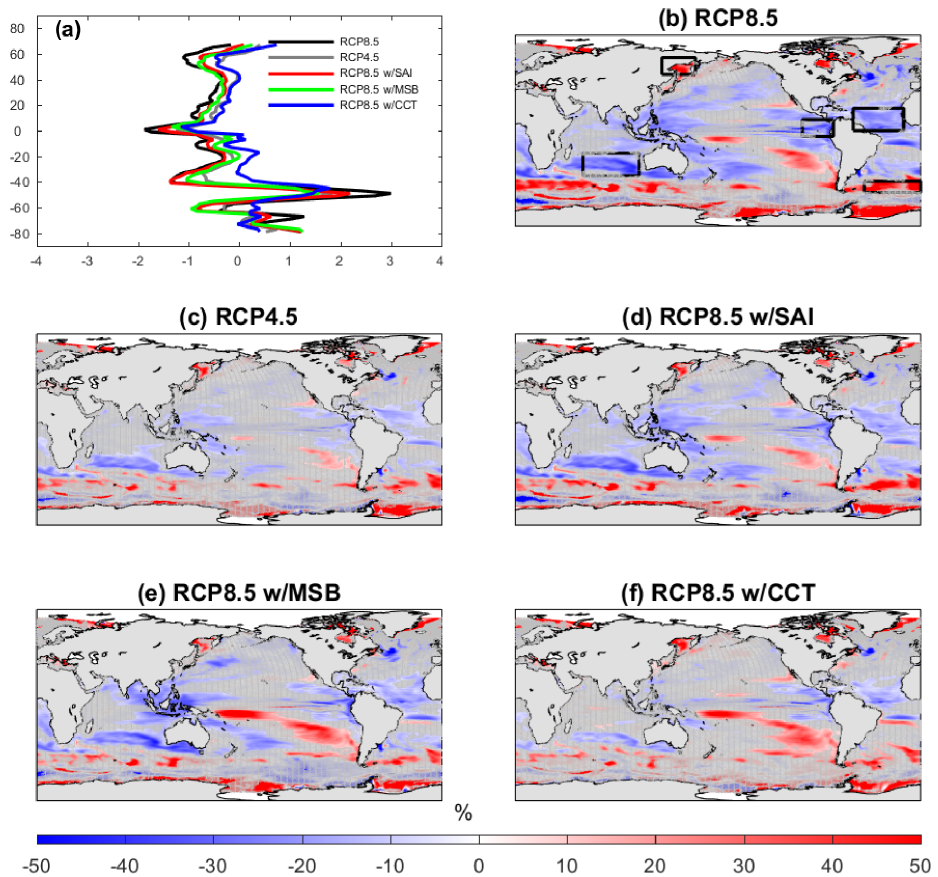
Figure 8. The percent change in the offline-calculated NPP in 2071–2100 relative to the 1971–2000 average in the historical run. (a) Zonally averaged (in 2 ◦ latitude bands) change for all simulations. (b) RCP8.5, (c) RCP4.5, (d) RCP8.5 with SAI, (e) RCP8.5 with MSB, (f) RCP8.5 with CCT. Gray shading in panels (b–f) indicates areas where the change is not significantly different from the 1971–2000 average (i.e., within 1 standard deviation of the 1971–2000 mean). The outlined areas in panel (b) indicate regions plotted in Fig. 9.